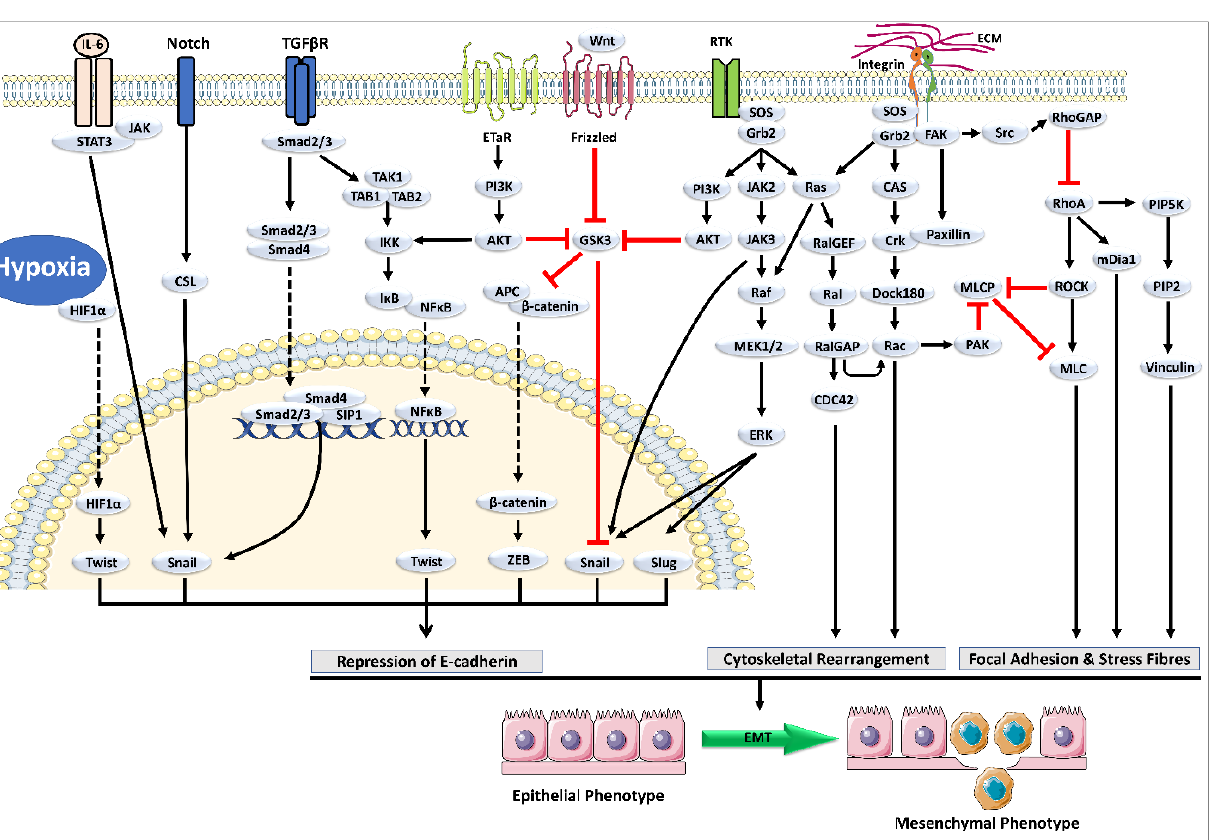
Figure 2. Illustrates the different pathways involved in initiating epithelial-mesenchymal transition (EMT)